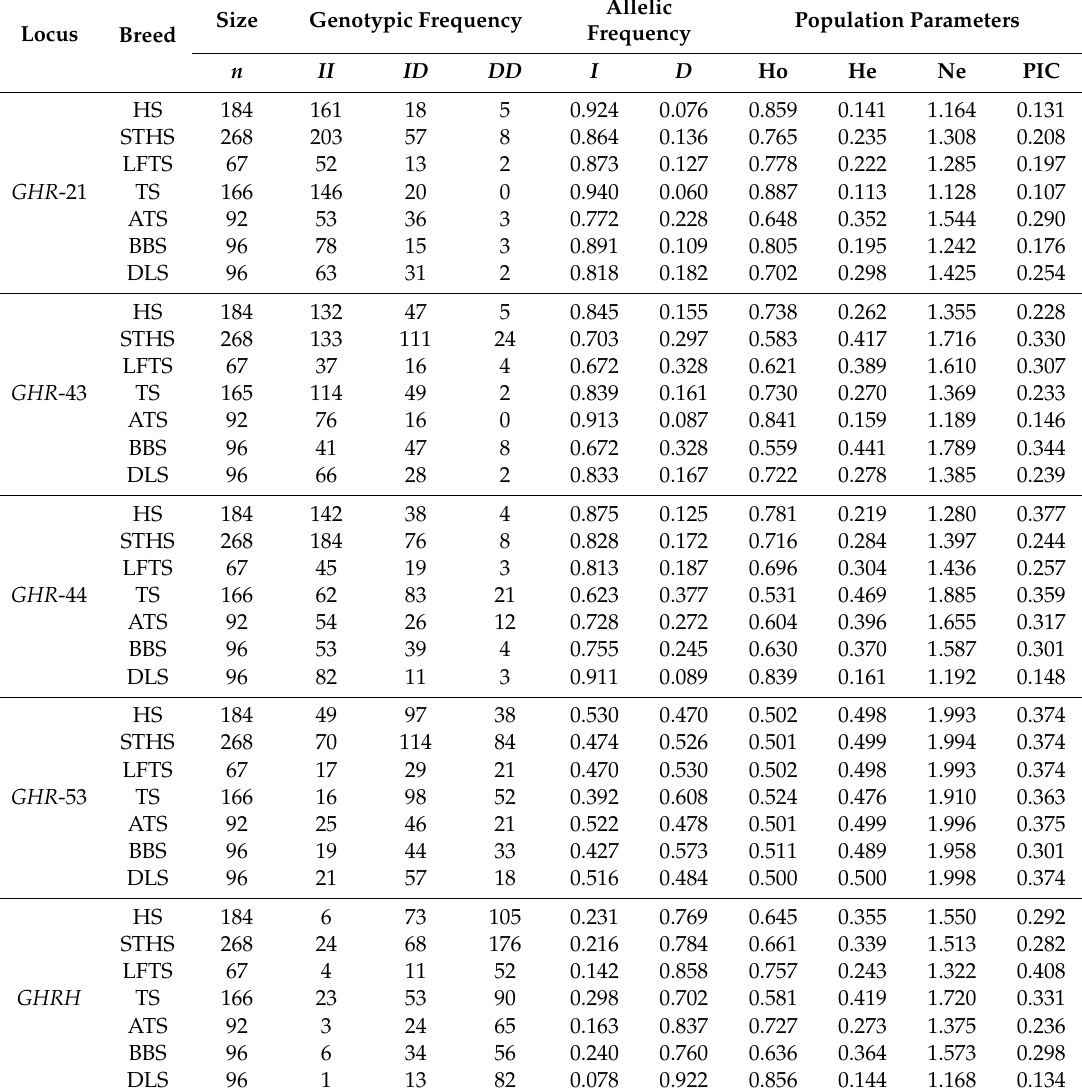
Table 3. Genotypes, alleles, He, Ne, and PIC for InDels of the sheep GHR , GHRH, and